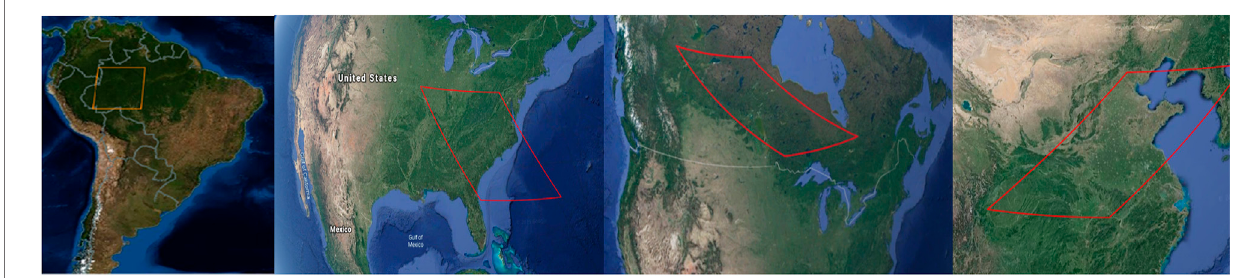
FIGURE 1 | Location of four MODIS tiles (from left to right: H11V09, H11V05, H12V03 and H27v05).